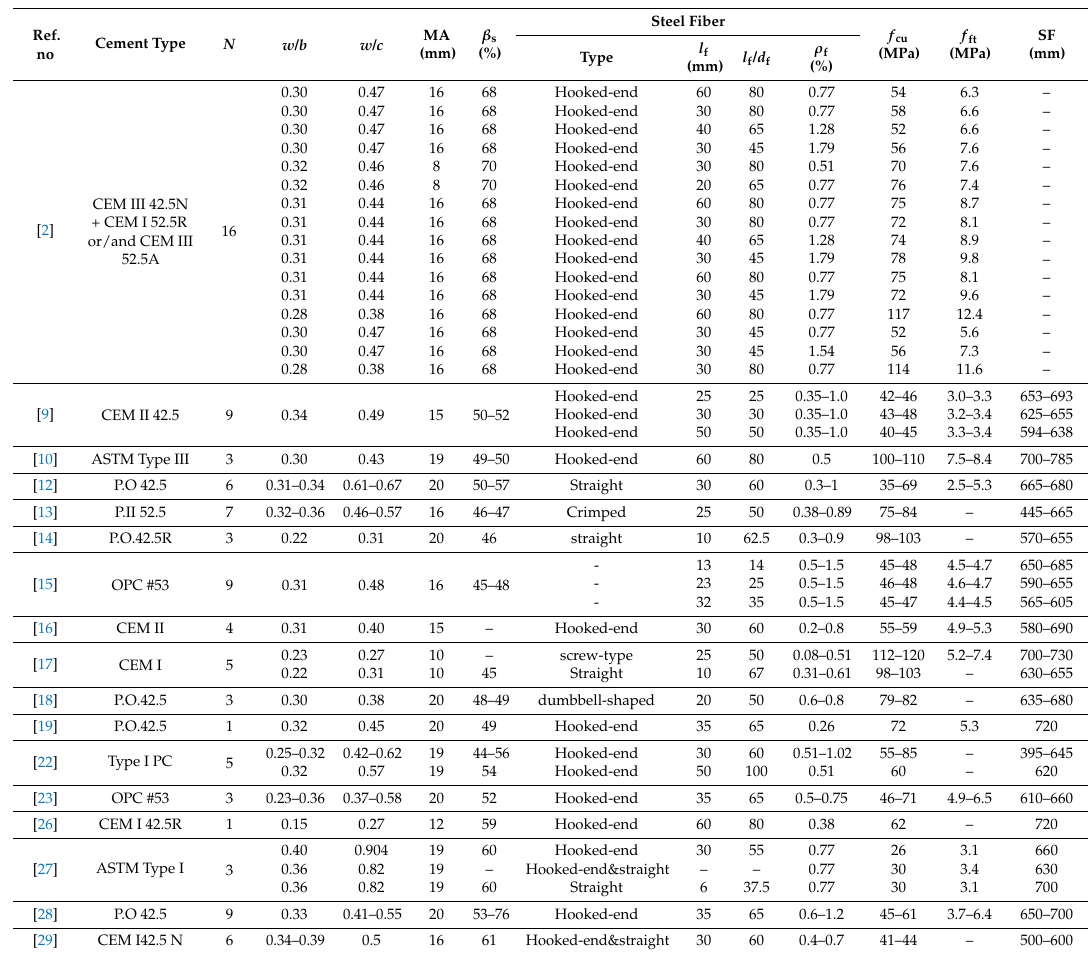
Table A1. Ranges of main parameters of